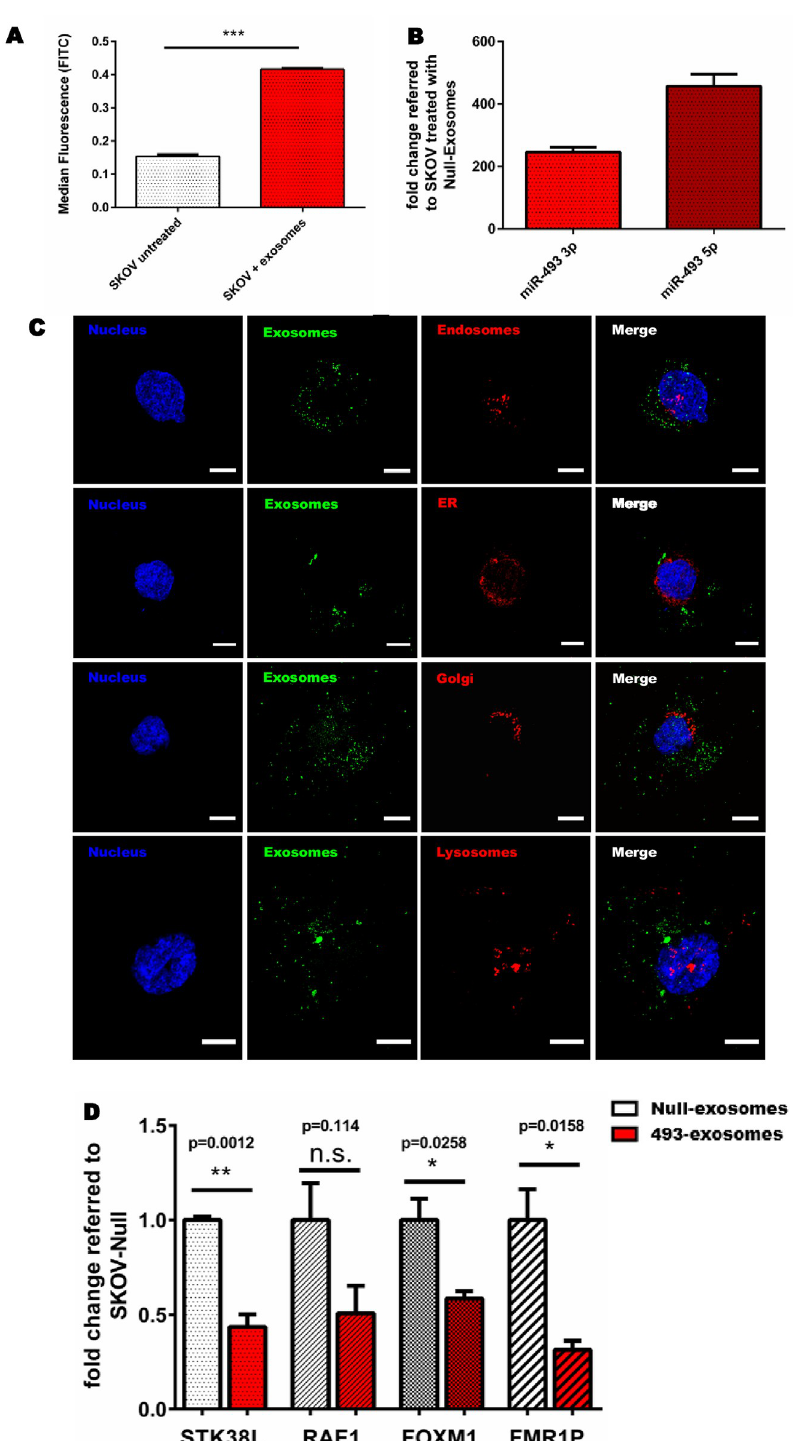
Fig 4. Uptake of exosomes from non-tumorigenic origin by ovarian cancer SKOV3 cells. ( A ) Flow cytometric analysis of GFP-positive SKOV3 cells after co-culturing with CD63-GFP containing exosomes. Significance was calculated employing unpaired t-test [n = 3 replicates; mean ± SD; ���� p < 0.0001]. ( B ) qPCR on SKOV3 cells, co- cultured with miRNA-493 pre-loaded CAP exosomes. Fold change calculations referred to miRNA-Null exosomes treated SKOV3 cells. U6 served as loading control. ( C ) Confocal microscopy images of SKOV3 cells stained for